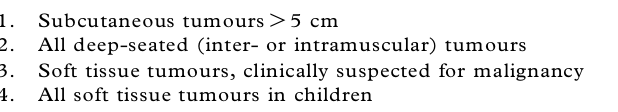
Table 2. Recommended guidelines for referral of patients with soft